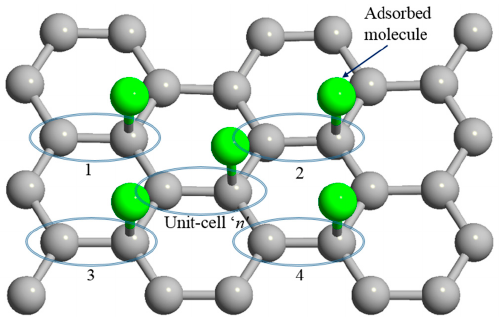
th unit cell and neighbor unit